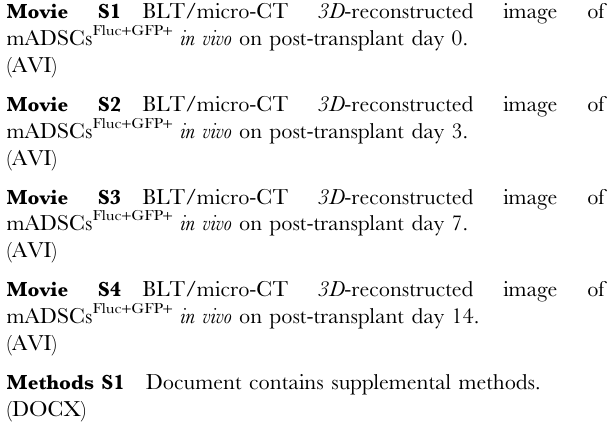
administration (b). Error bars: mean 6 SD. (TIF) Figure S3 Assessment of hindlimb angiogenesis following treatment of mADSCs with inhibitors of VEGF/mTOR/Akt pathway. Immunofluorescence assay (a) demonstrated that combined treatment of anti-VEGF monoclonal antibody (mAb), PP242 or triciribine with mADSCs abrogated mADSC-mediated angiogenesis (b). n =20 random fields. Scale bars represent 50 m m. Error bars: mean 6 SD. { P , 0.001 vs. Control, ** P , 0.001 vs.